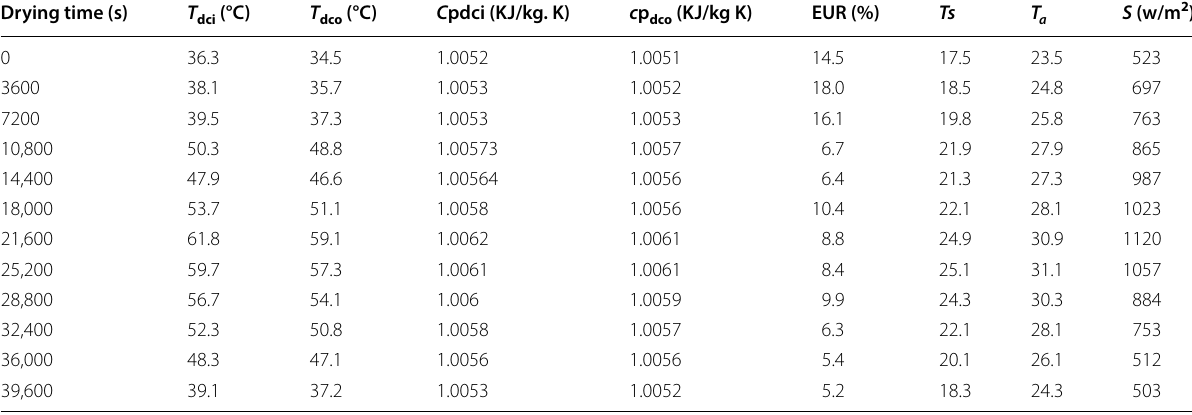
Table 19 Result energy analysis onion 1st day